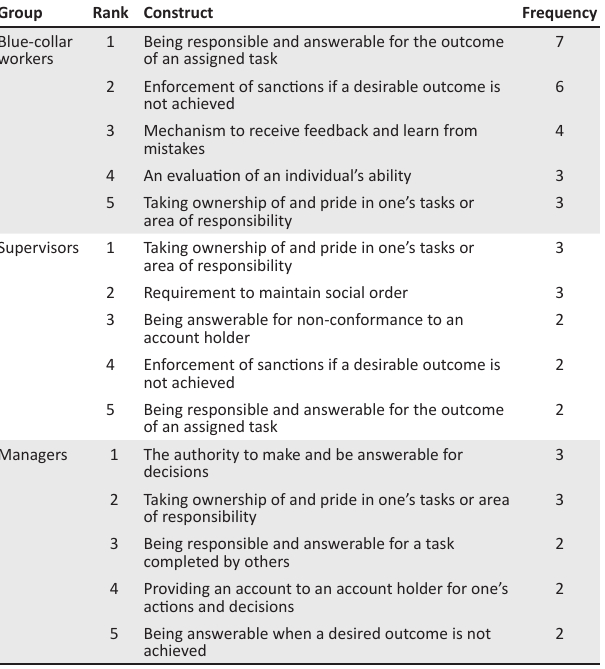
TABLE 3: Understanding the concept of